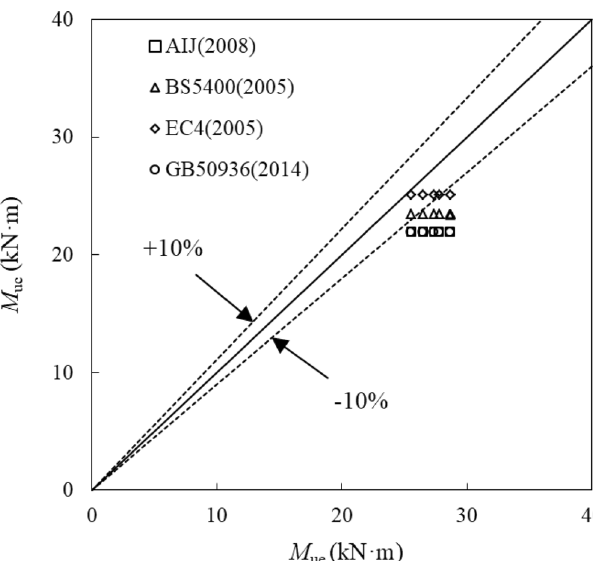
Figure 9. Comparison of calculated bending moment ( M uc ) and test bending moment ( M ue